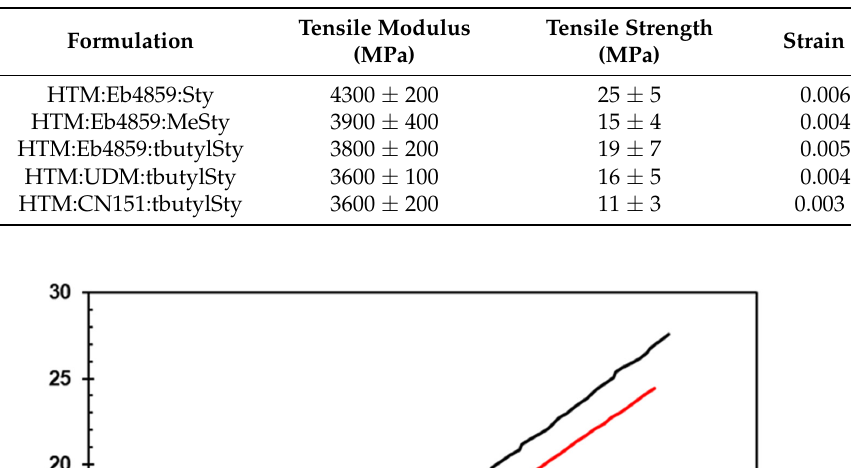
Table 8. Summary of the tensile test data of 3D printed HTM thermosets.